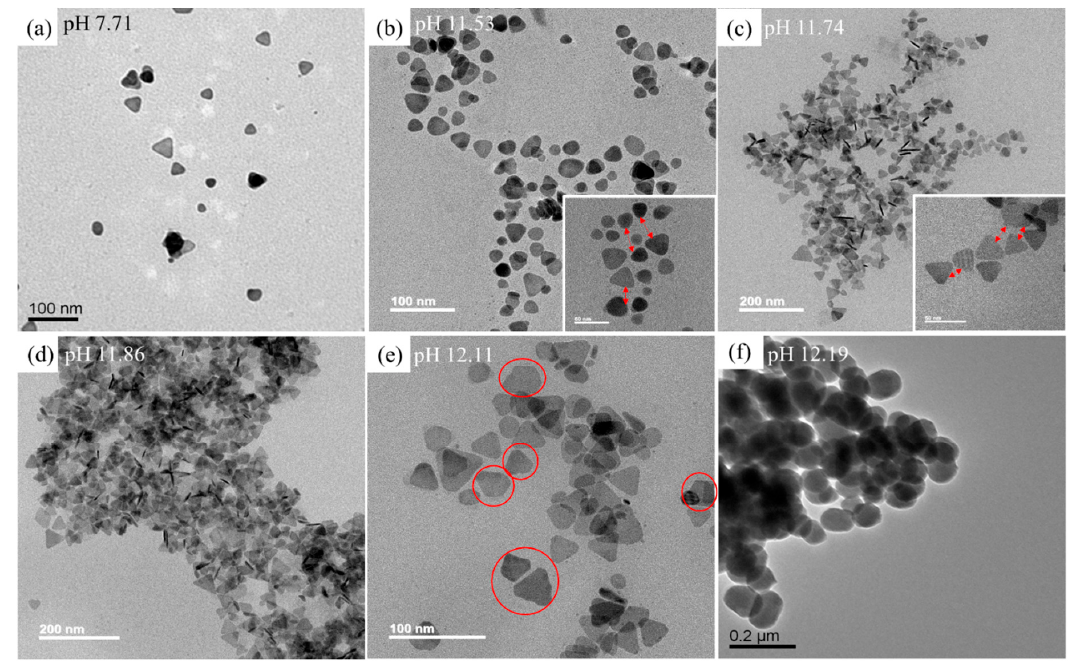
Figure 3. TEM images upon additions of different concentrations of Xan: ( a ) 0 μ M, ( b ) 0.27 μ M, ( c ) 0.57 μ M, ( d ) 0.91 μ M, ( e ) 2.86 μ M and ( f ) 3.90 μ M ; and the respective pH values of individual